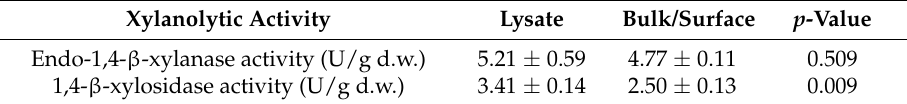
Table 3. Xylanolytic activities of the naturally-fermented orange juice processing waste.